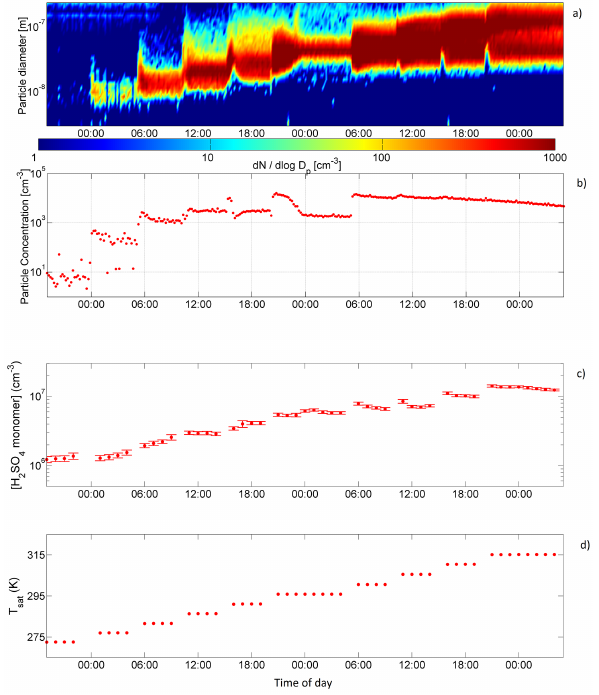
Figure 5. DMPS and CIMS data from one T sat cycle. (a) shows the number size distribution, (b) shows the total number concentration from DMPS, (c) shows the CIMS-measured sulfuric-acid monomer concentration averaged over 1h with standard deviation as error bars and panel (d) shows hourly averaged temperature of the sat- urator.